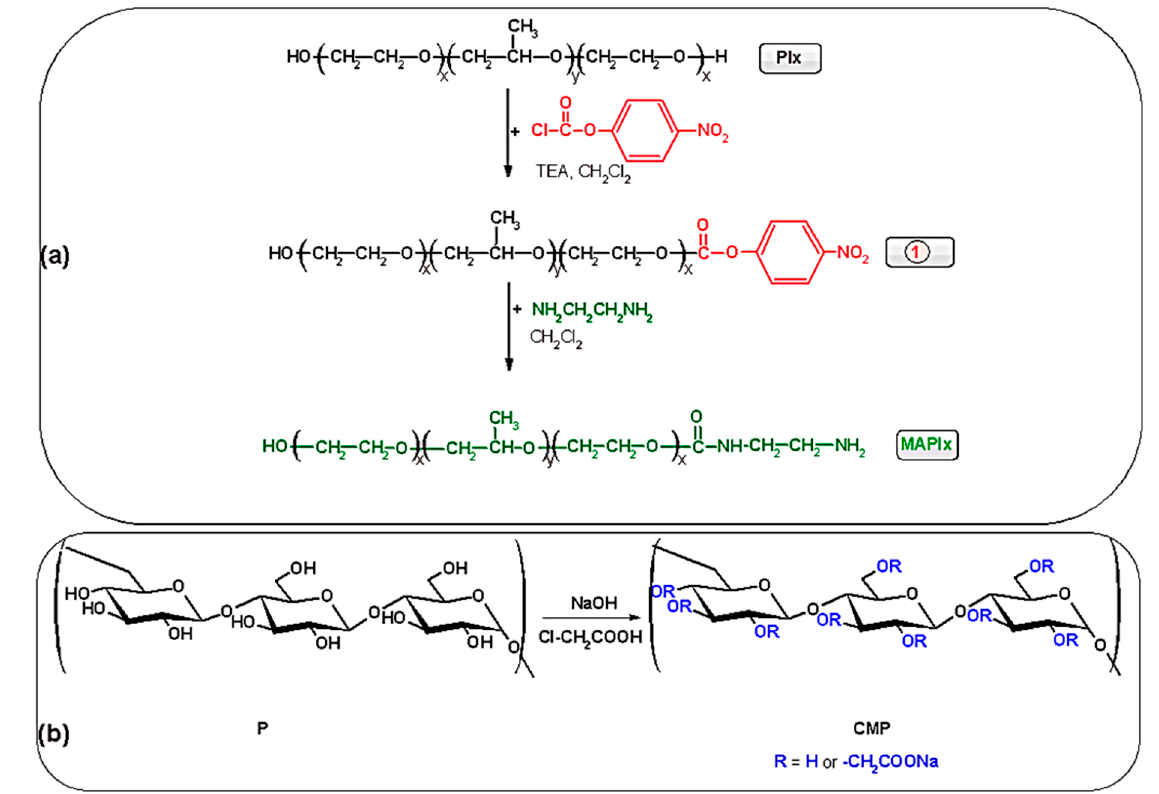
Scheme 2. Synthesis route of monoamine derivative of poloxamer (MAPlx) ( a ) and carboxymethyl pullulan ( b ).